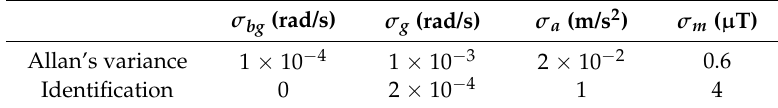
Table A1. Values of measurement noise identified by the method of the Allan variance and Kalman parameters identified for slow movements.